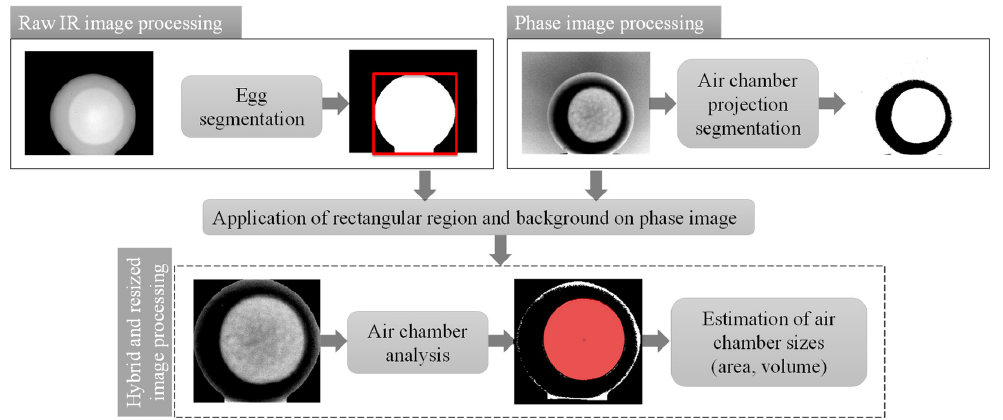
Figure 6. Block diagram of the algorithm used to estimate air chamber size from the front view using both raw and phase infrared images.